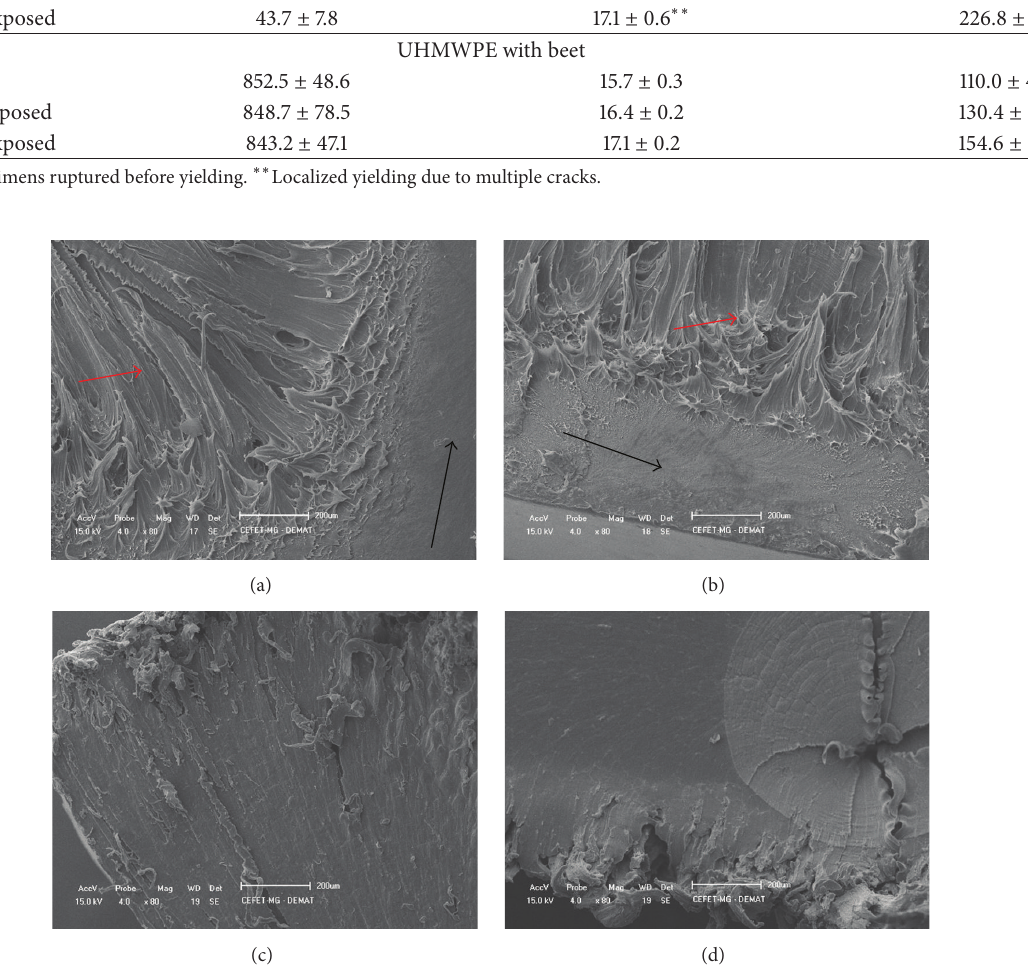
Figure 9: Fracture surface of tensile specimens after stress strain test: (a) UHMWPE with annatto after 42 days of UV exposure, (b) neat UHMWPE after 42 days of UV exposure, (c) UHMWPE with beet after the same time of UV exposure, and (d) UHMWPE with annatto after 21 days of UV